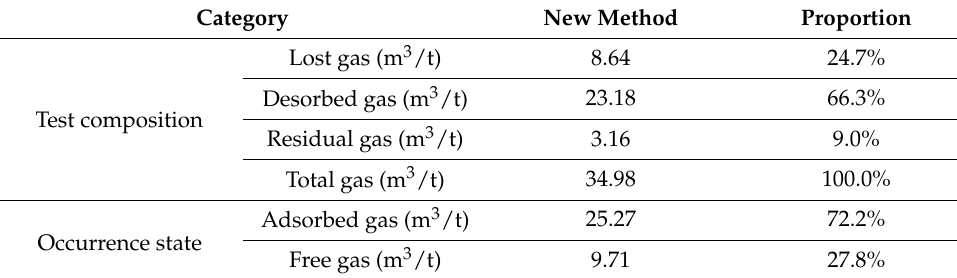
Table 3. Sample Calculation and Interpretation Results from the New Method.